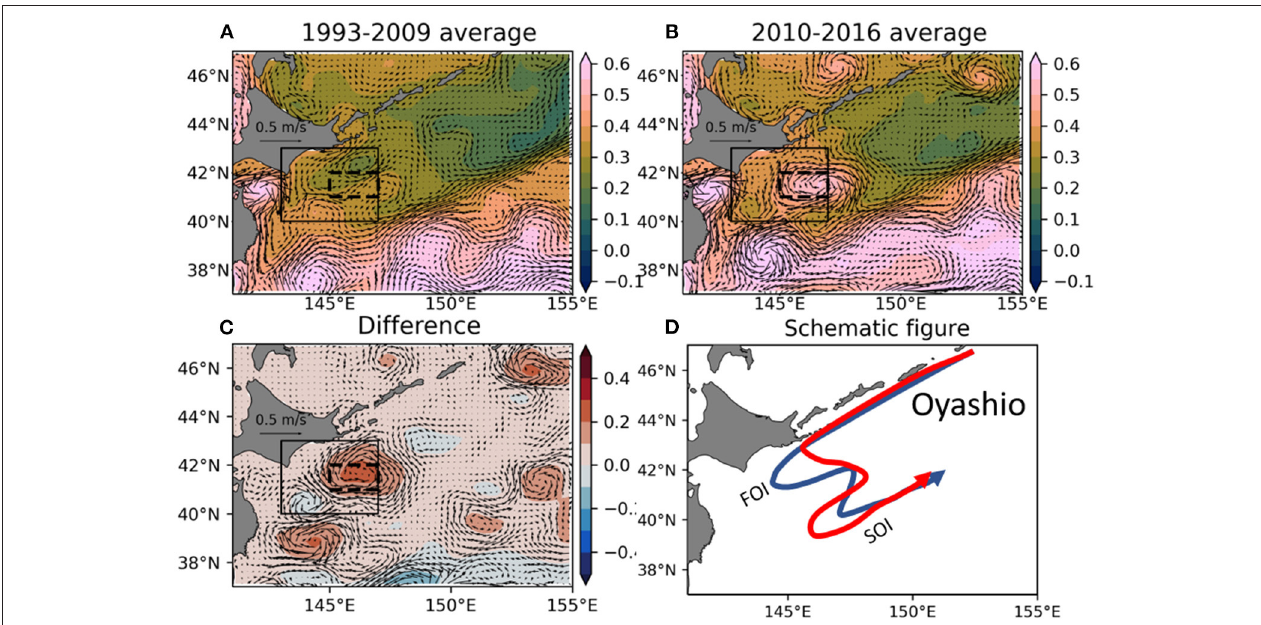
FIGURE 6 | The absolute dynamic heights (color; m) and the corresponding geostrophic velocities (vectors; m s − 1 ) estimated by the altimeters. (A) The 1993–2009 average. (B) The 2010–2016 average, (C) the difference between (B) and (A) . (D) Schematic figure of the Oyashio Current in 1999–2009 (blue line) and in 2010–2016 (red line). The first and second crests of the meandering Oyashio Current from the west to the east are the First Oyashio Intrusion (FOI) and Second Oyashio Intrusion (SOI), respectively.